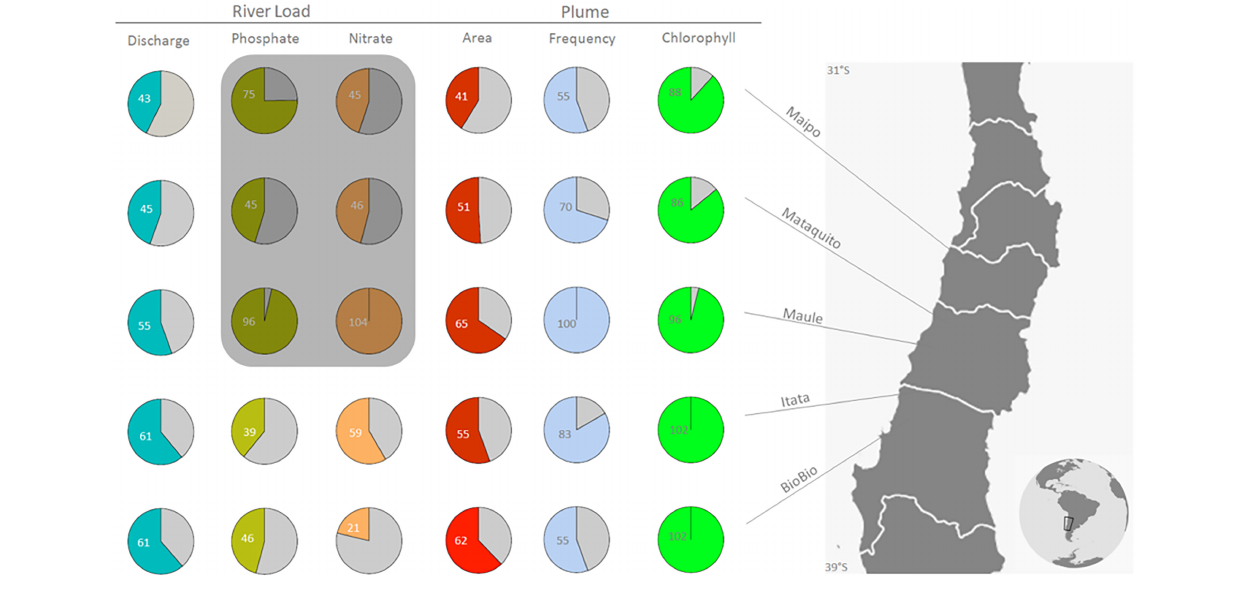
FIGURE 6 | Impact of mega-drought in coastal areas off Central Chile in terms of river load (Discharge; m 3 s − 1 , Phosphate-PO 4 − 3 and Nitrate- NO 3 − export; Ton month − 1 ), river plume area (km 2 ), frequency, and phytoplankton biomass (Chlorophyll; mg m − 3 ). Numbers and colored areas indicate the mega-drought (2010–2014), mean values as a percentage of the averages over the past decade (2000–2009) for five rivers in Central Chile. Shadow box indicates that Maipo, Mataquito, and Maule Rivers only have Phosphate-PO 4 − 3 and Nitrate- NO 3 − export data until